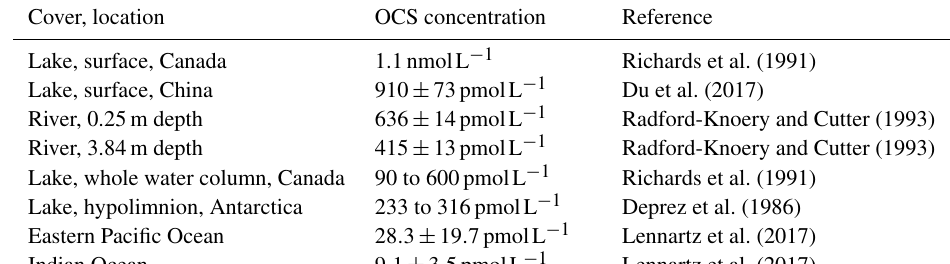
Table 2. OCS concentrations observed in rivers and lakes compared to ocean observations in Lennartz et al. (2017).